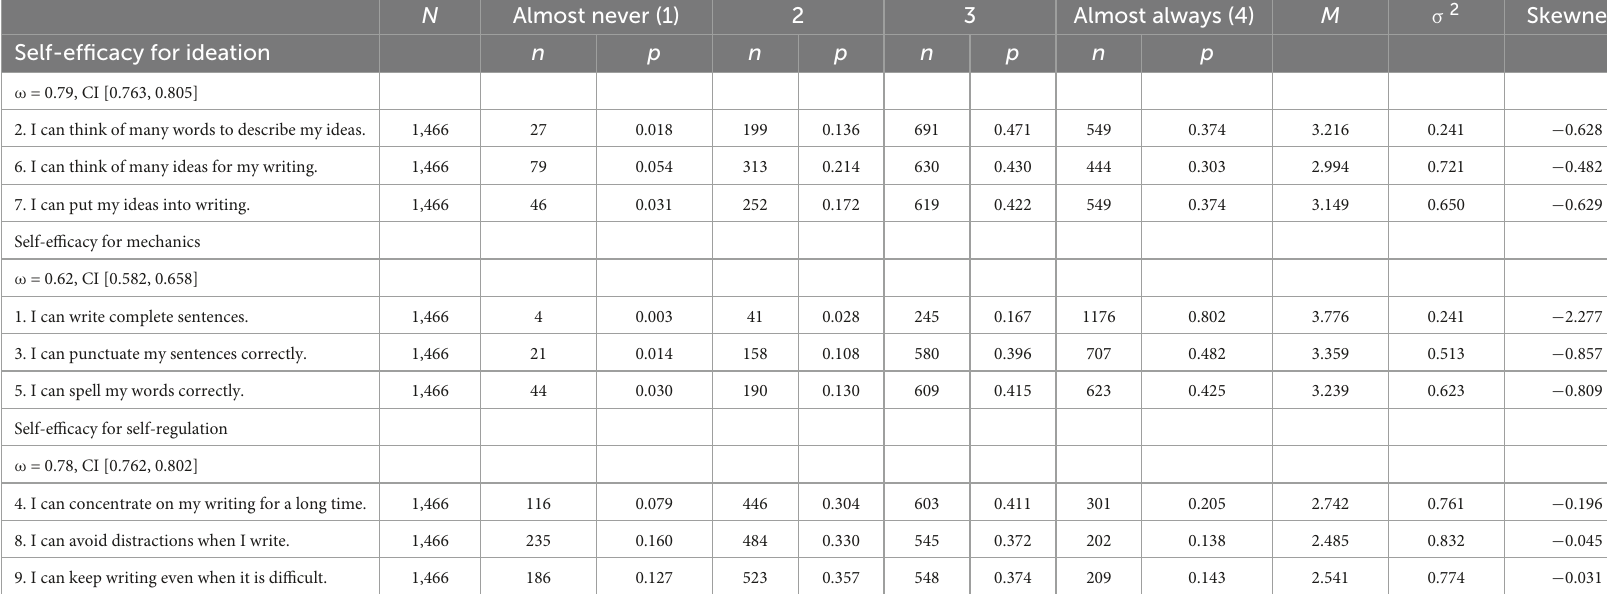
TABLE 2 Adapted Self-Efficacy for Writing Scale response frequencies and descriptive